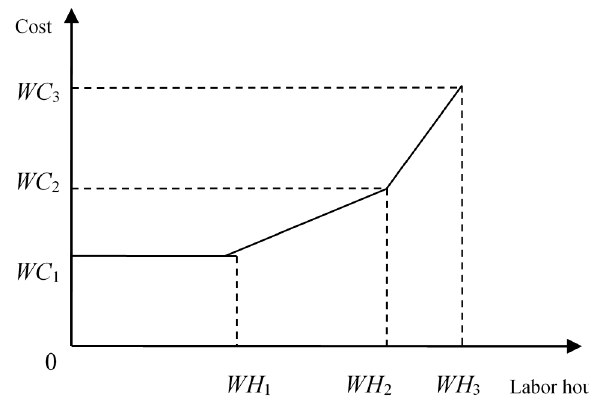
Figure 7. Direct labor cost.